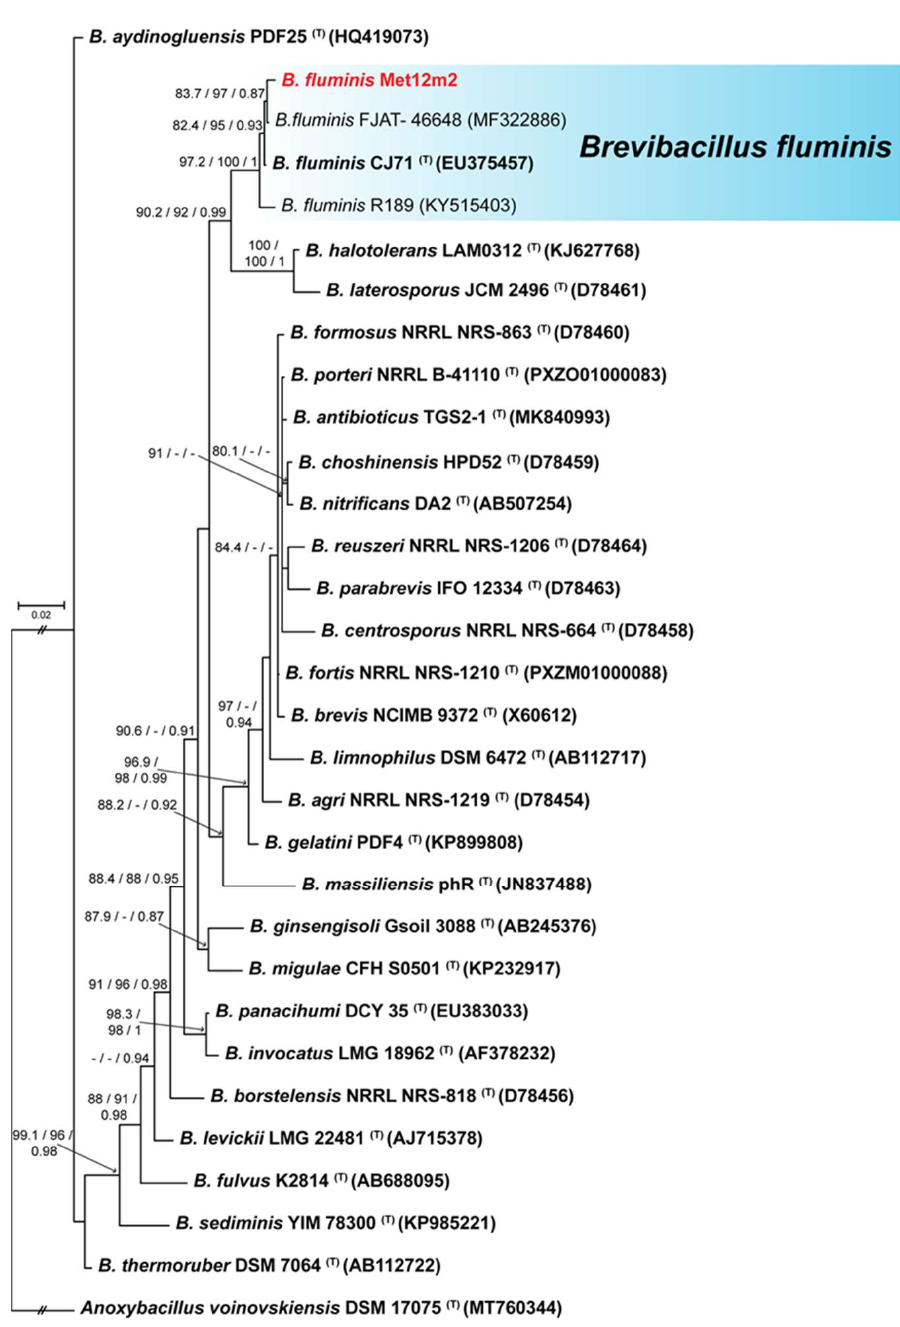
Figure 3. Bayesian inference phylogenetic tree of MET12M2 isolate and 27 species of Brevibacillus based on 16S rDNA sequences. The species Anoxybacillus voinovskiensis (DSM17075) was used as outgroup. Strains marked with a “T” and emphasized in bold correspond to sequences from type- strains. The scale bar of 0.02 represents the number of changes per site. MLsh-ALRT, ultrafast bootstrap values, and posterior probability support values are presented on the left side of nodes.